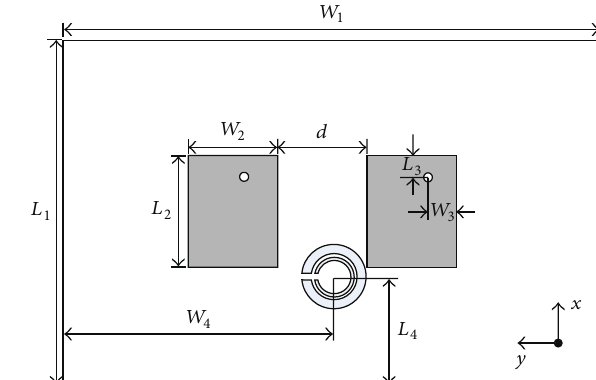
Figure 6: The geometry of the patch array.